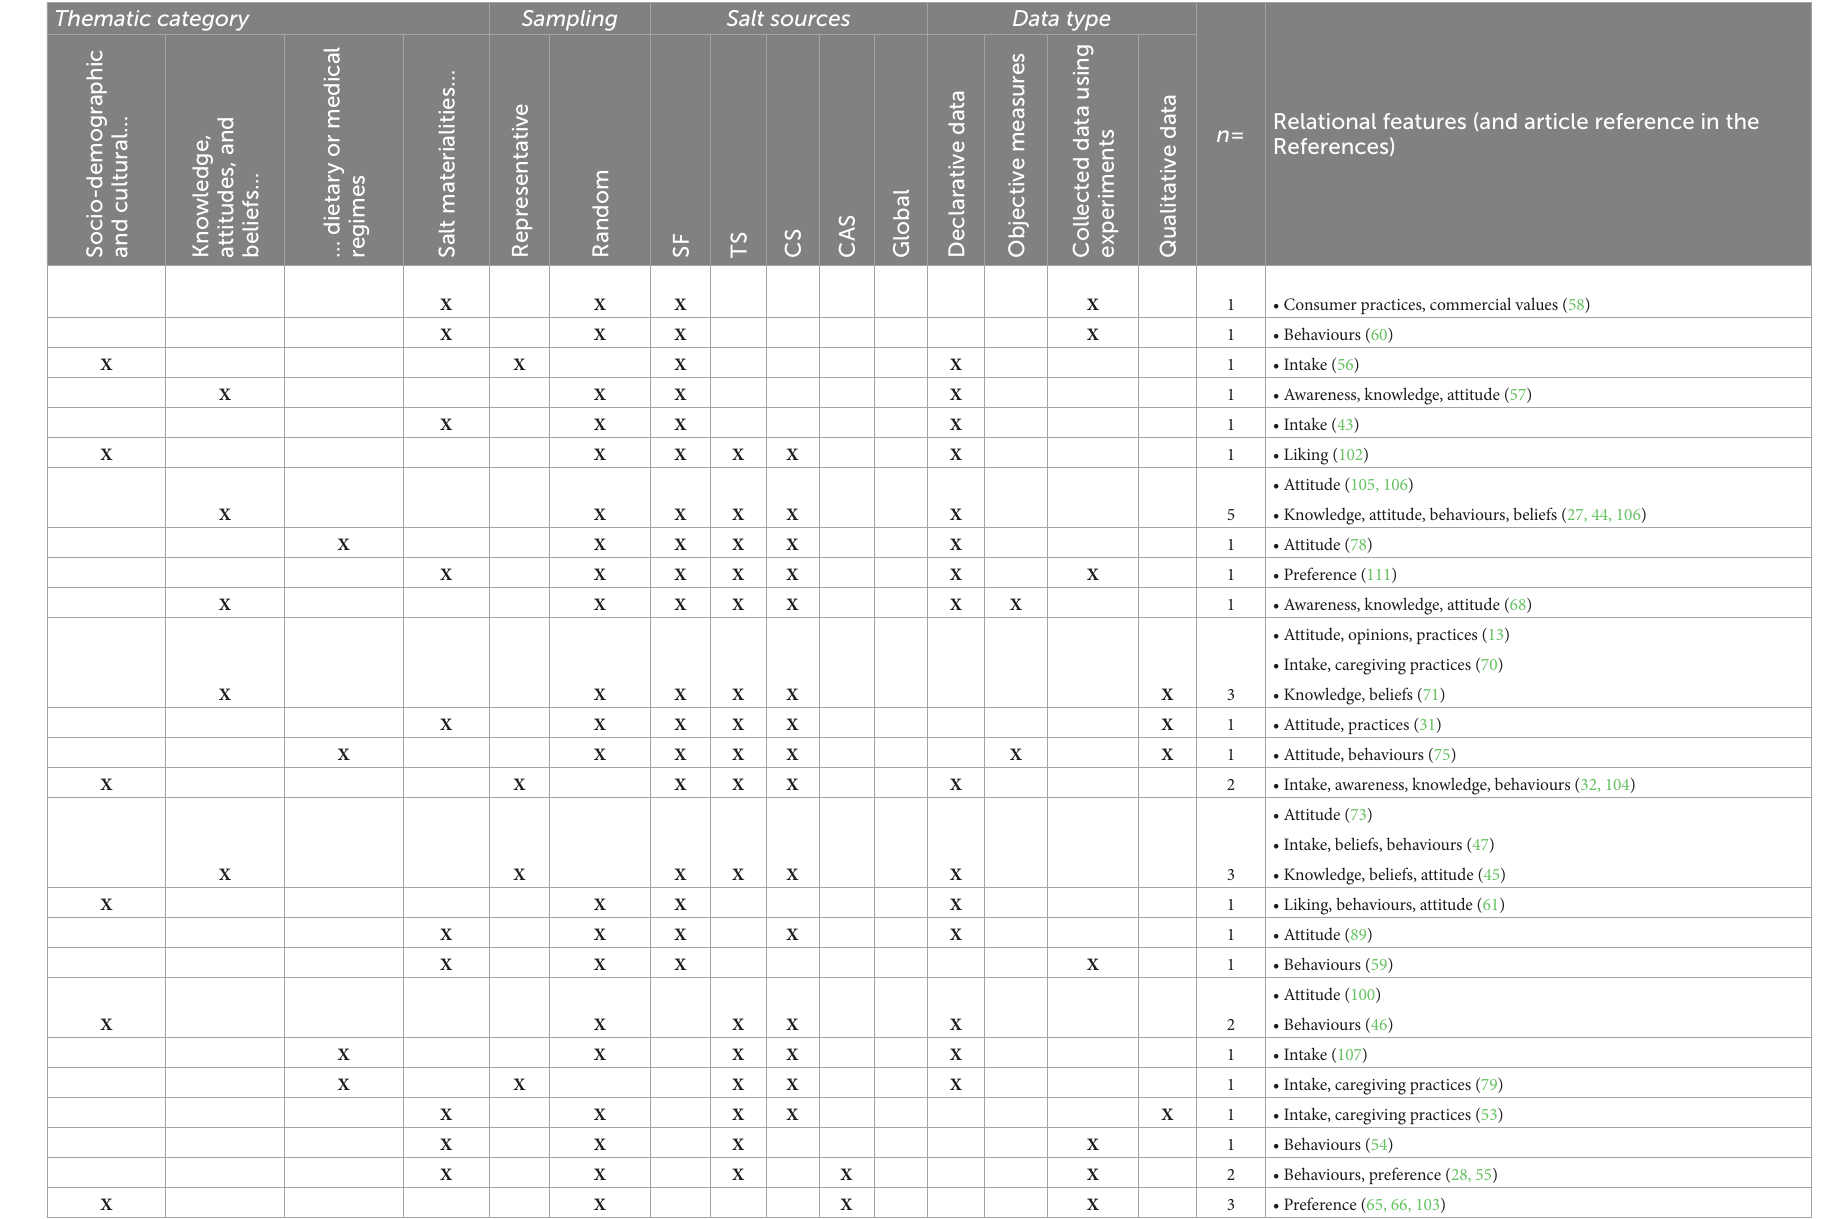
TABLE 1 Corpus synthesis through the eater-oriented